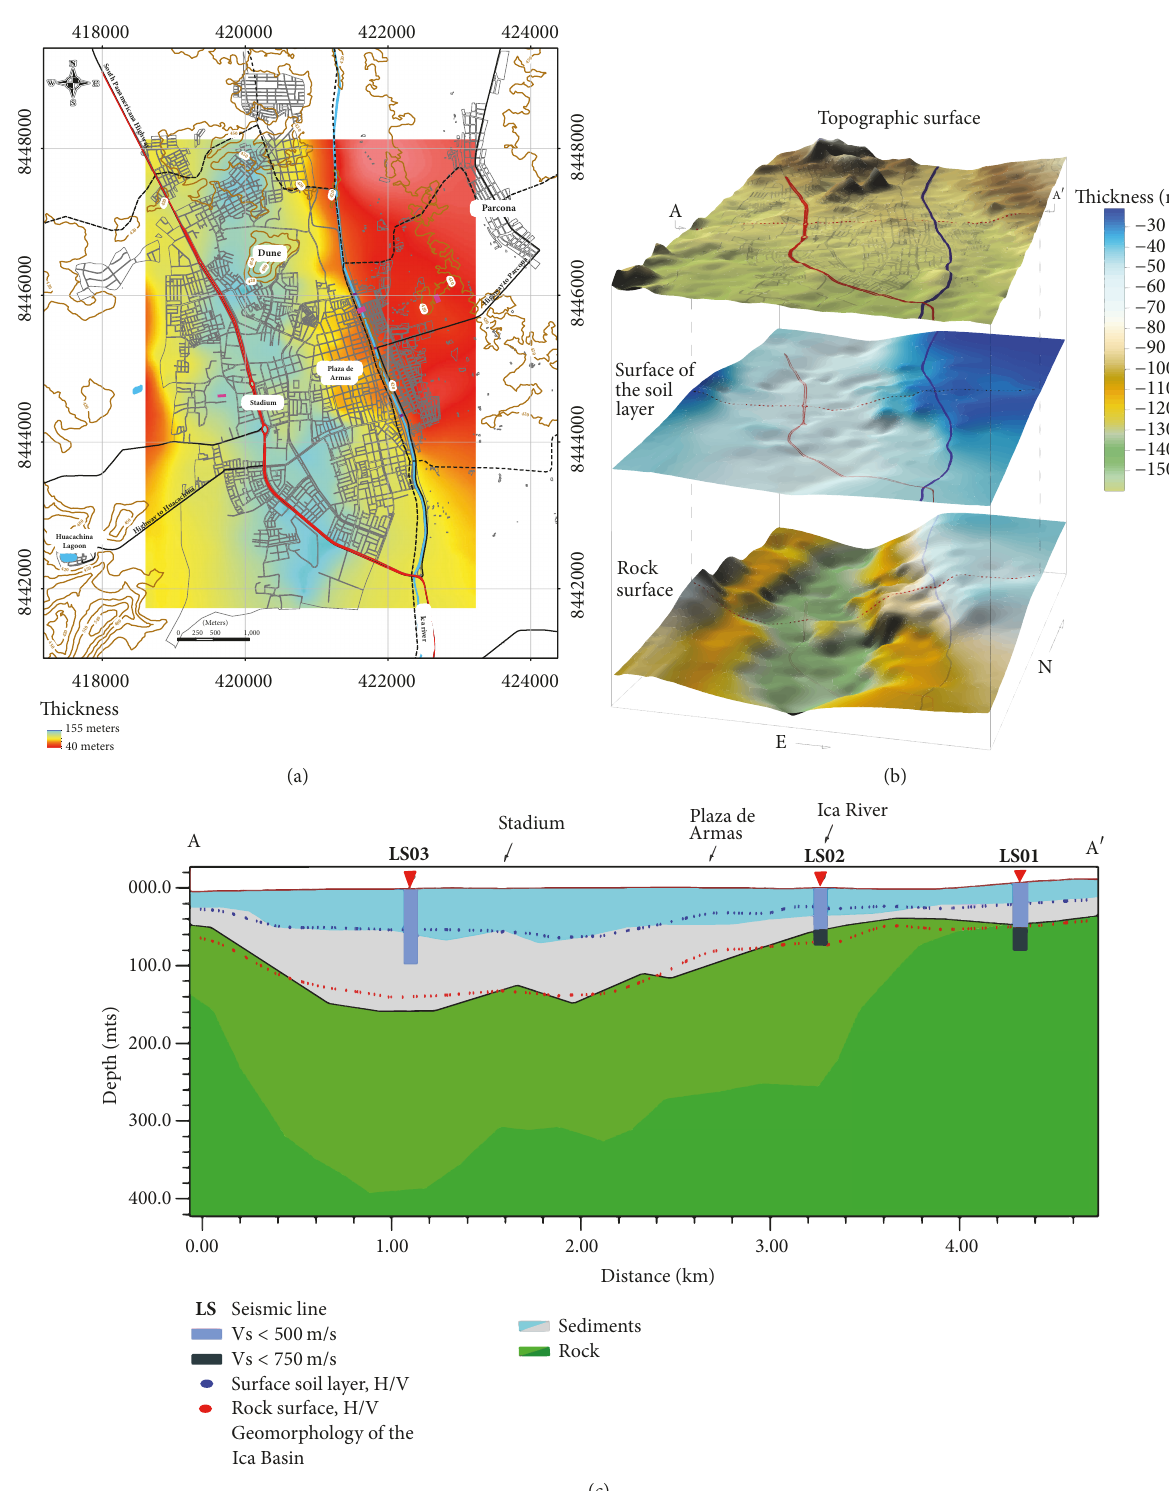
Figure 7: (a) Contour depth map derived from the predominant frequencies; (b) 3D schema of the Ica Basin; and (c) cross section of the Ica Basin (A-A 󸀠 ), superposed on the results obtained using seismic and gravimetric